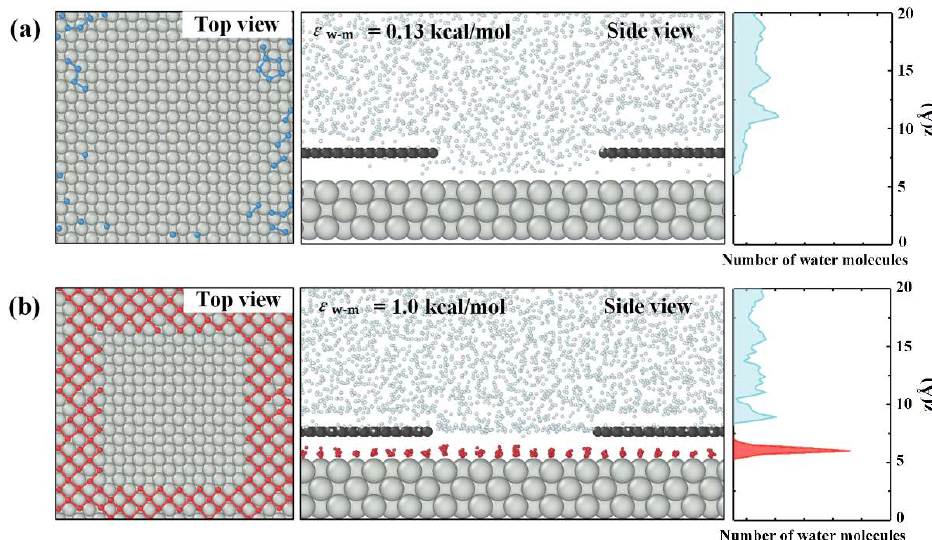
Figure 3. The formation of an interfacial water layer on a metal–graphene nanosheet surface. ( a ) Snapshot of the interface between a metal substrate and liquid water. The dense interfacial water layer was not formed at ε w-m = 0.13 kcal/mol. ( b ) Snapshot of the interfacial water layer viewed from the top and the side. The right panel is the number of water molecules along the z direction before water freezing. In all cases, the interfacial water layer is colored red for ease of visualization.